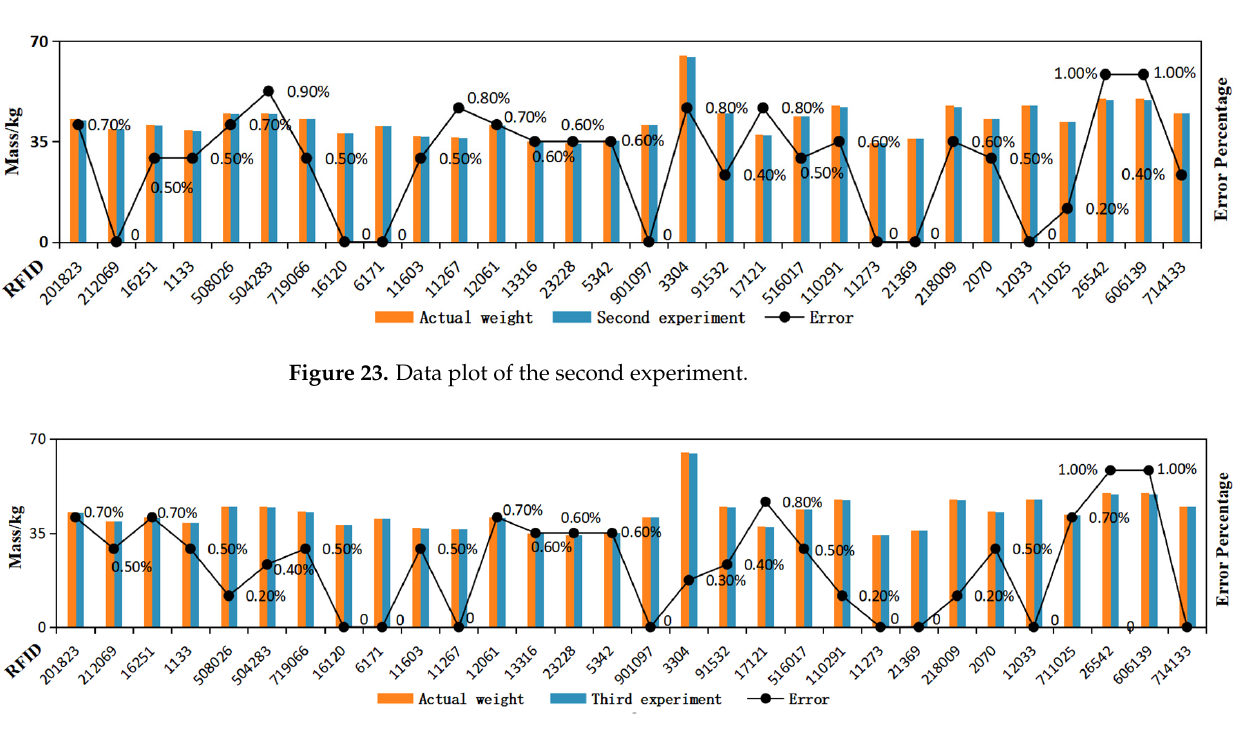
Figure 22. Data plot of the fi rst experiment.